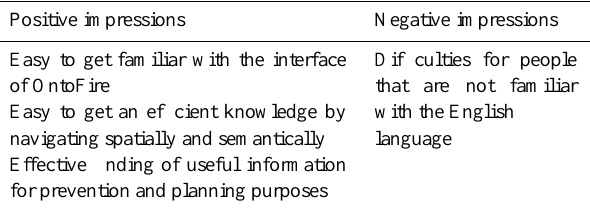
Table 1. Positive and negative impressions of